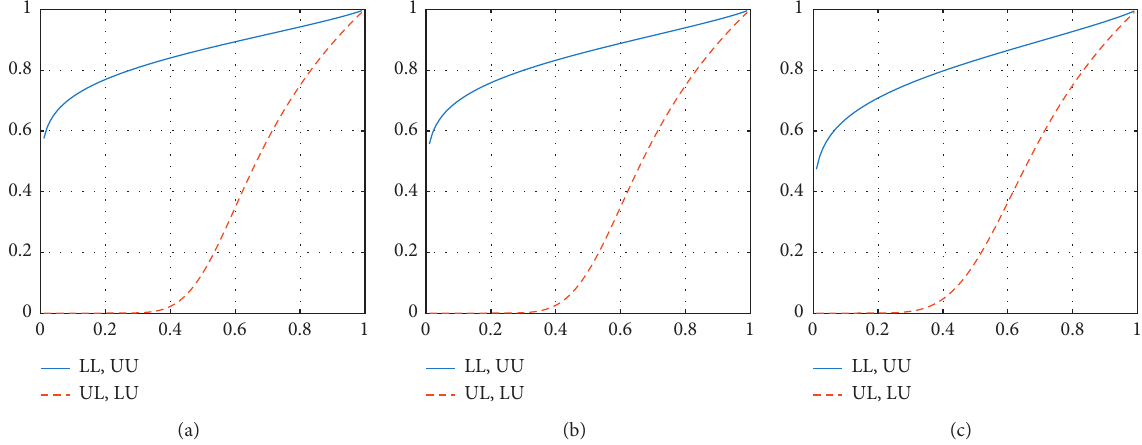
Figure 13: QD curves of the bivariate CCC-N copula model. (a) HSI-CEI. (b) HSI-CCI. (c)